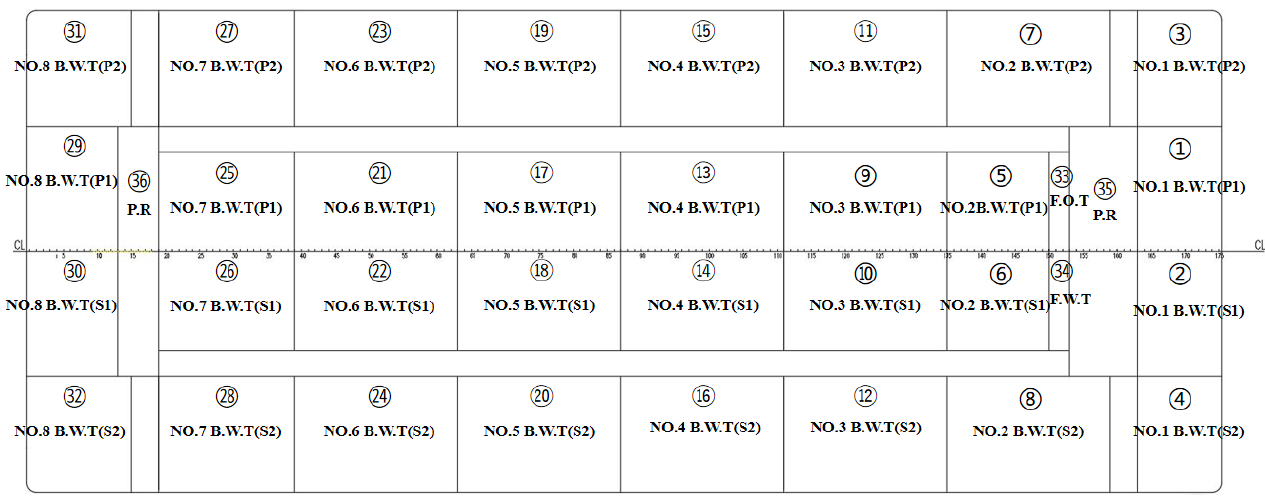
Figure 2. Top view of ballast water tank.